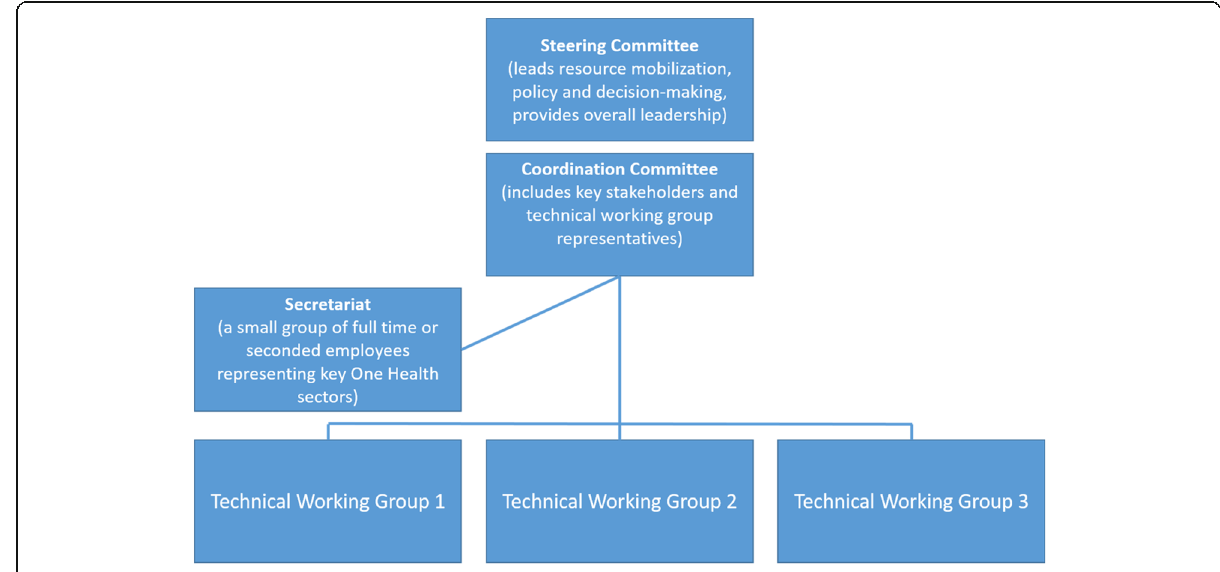
Fig. 3 Main features of the platform organizational